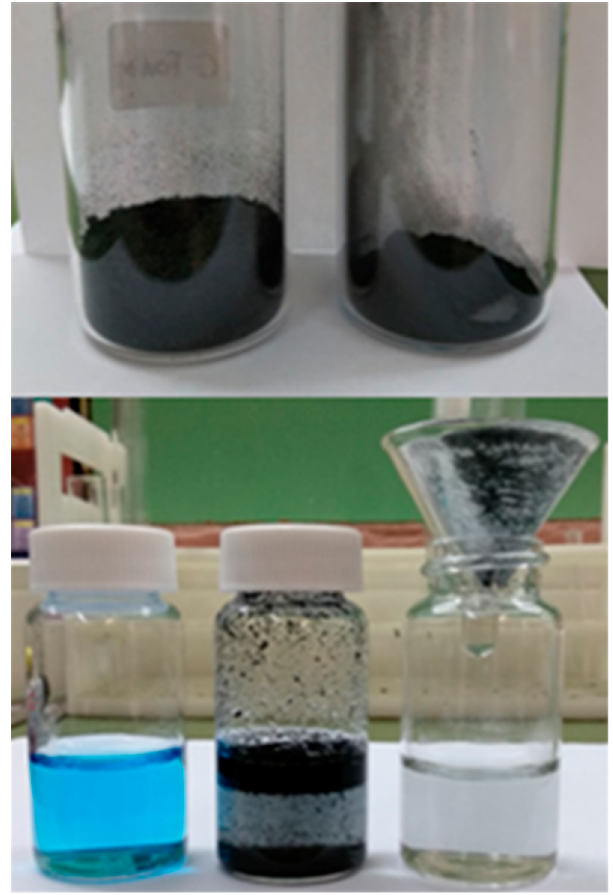
Figure 10. Top : The vial on the left shows the volume of the lightweight carbon versus that of commercial charcoal (right vial). Both vials contained 180 mg of the material. Bottom : Addition of the lightweight carbon to an aqueous solution of the organic dye methylene blue and subsequent filtration resulted in decolorization of the aqueous phase.